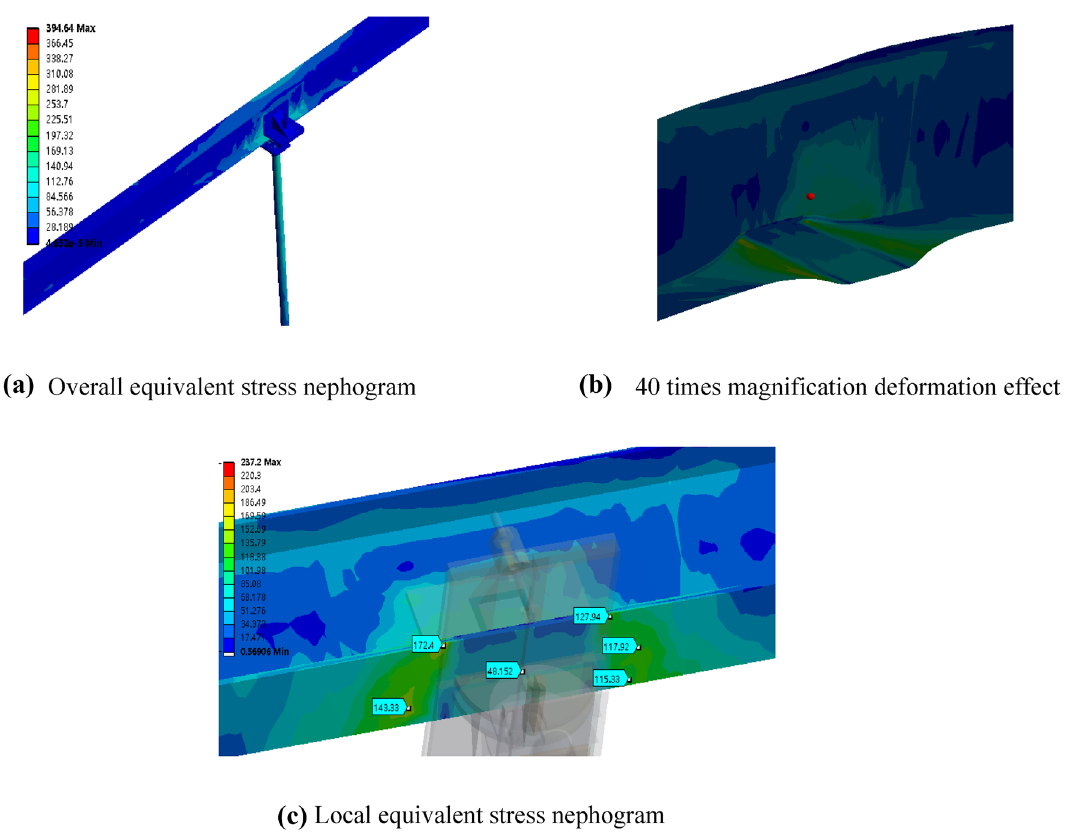
Fig. 11 Equivalent stress nephogram of strut joint corresponding to bottom flange of